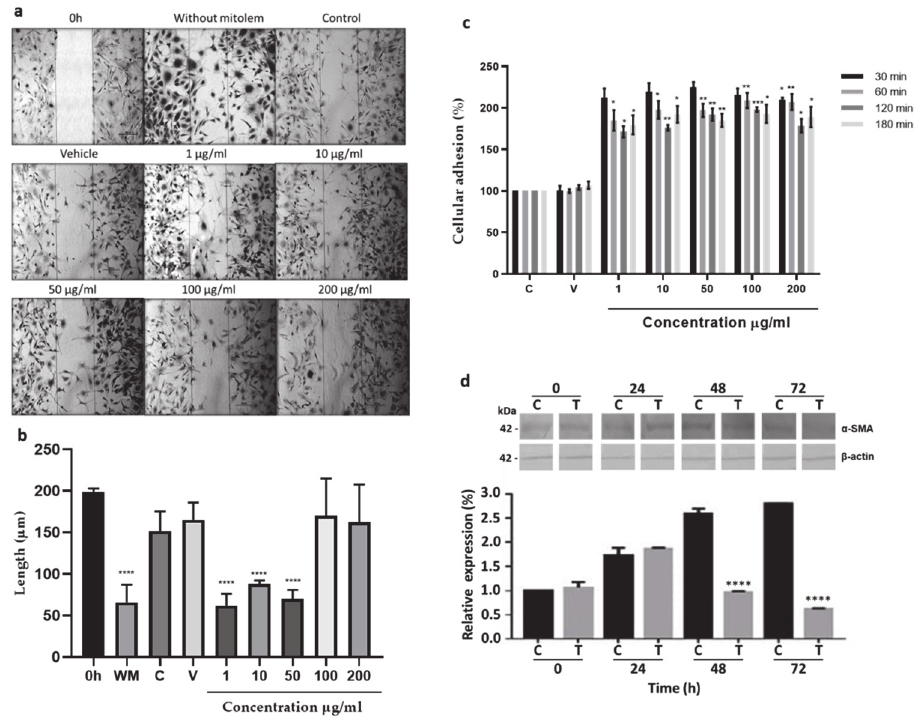
Figure 2. In vitro effects on 3T3 fibroblast. ( a ) Migration. Cells were grown at 80% confluence, and scratch was conducted (0 h). The 3T3 fibroblasts were grown with 2% SFB supplemented media without mitomycin (WM), with 10 µ g/mL of mitomycin (control, C) to inhibit cell proliferation, with 10 µ g/mL of mitomycin and water (vehicle, V), or with mitomycin and different aqueous fraction concentrations (1, 10, 50, 100, and 200 μ g/mL) for 48 h. ( b ) The measure of the wound area, **** p < 0.0001 versus time 0. ( c ) Adhesion effect. Culture flasks were covered with fibronectin as described in methods. Cells were grown with 2% SFB supplemented media (C) and treated with 1, 10, 50, 100, and 200 µ g/mL of aqueous fraction at 30, 60, 120, and 180 min. Fibroblasts grown with 2% SFB-supplemented media (C) or with water (V) are shown; * p < 0.05, ** p < 0.005, *** p < 0.0005, **** p < 0.0005 versus control. Two-Way ANOVA, post hoc Tukey ´ s test. ( d ) Differentiation to myofibroblast. Fibroblasts were treated with 2% SFB supplemented media or with 10 µ g/mL of aqueous fraction (T) for 24, 48, and 72 h. Total protein extracts were prepared and analyzed by WB using a specific anti- α -SMA antibody for myofibroblast identification. As a loading control, anti- β actin antibody was used. The graph shows the densitometric analysis of α -SMA expression. Results are expressed as means and bar is SD. Two-Way ANOVA, post hoc Tukey’s